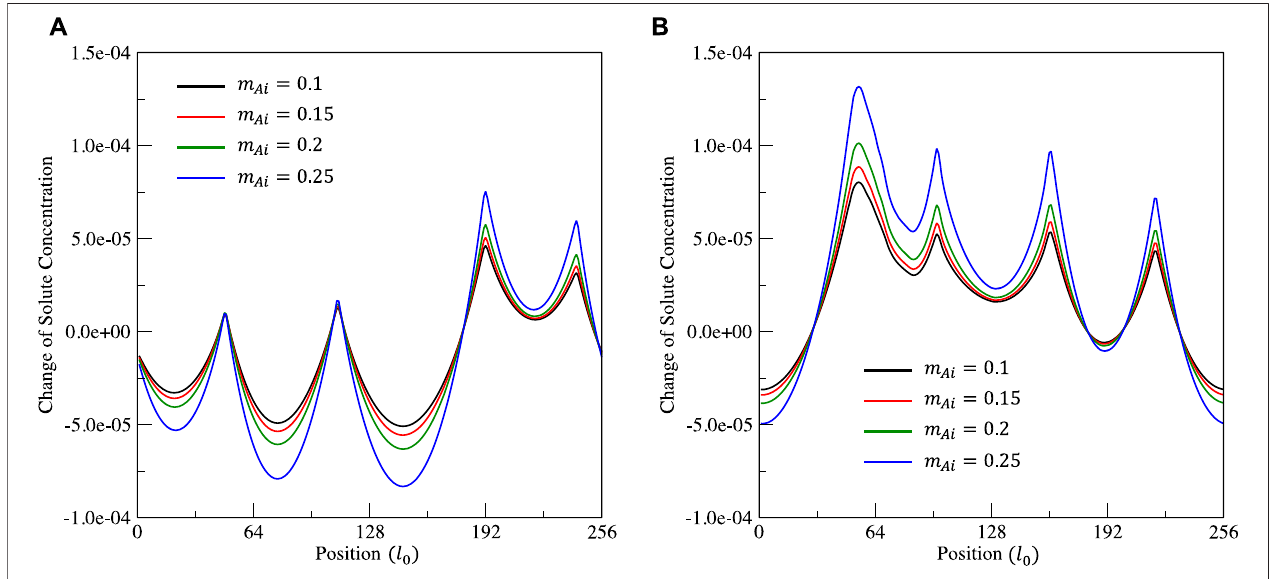
FIGURE8| Distributionofthesoluteconcentrationchange Δ c A attimet (cid:2) 8 . 17sfordifferentsoluteinterstitialproductionef fi ciency m Ai . (A) ontheline A 1 A 2 and (B) on the line BB ′ .